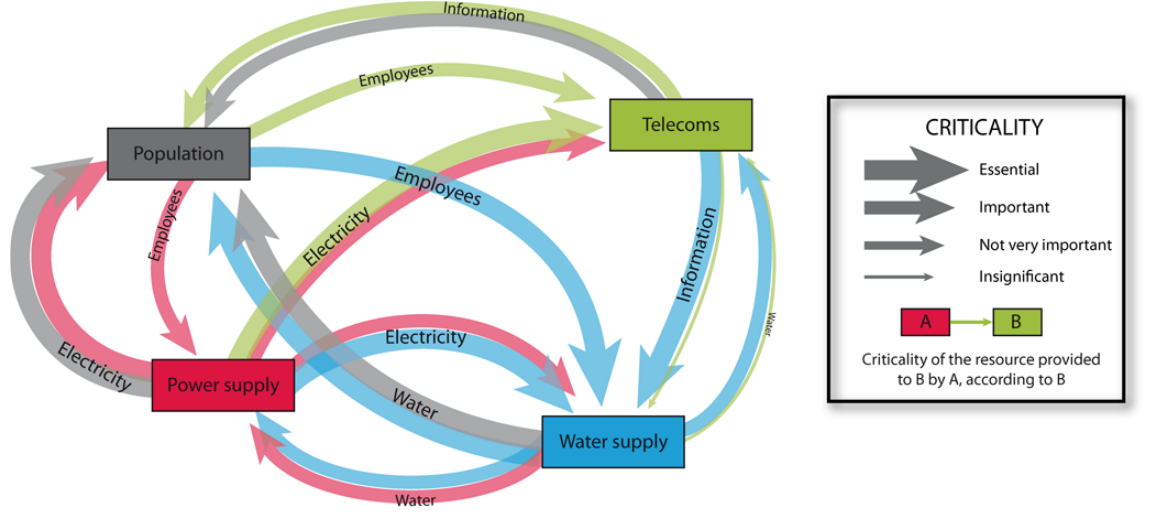
Fig. 4. Four interdependent systems.